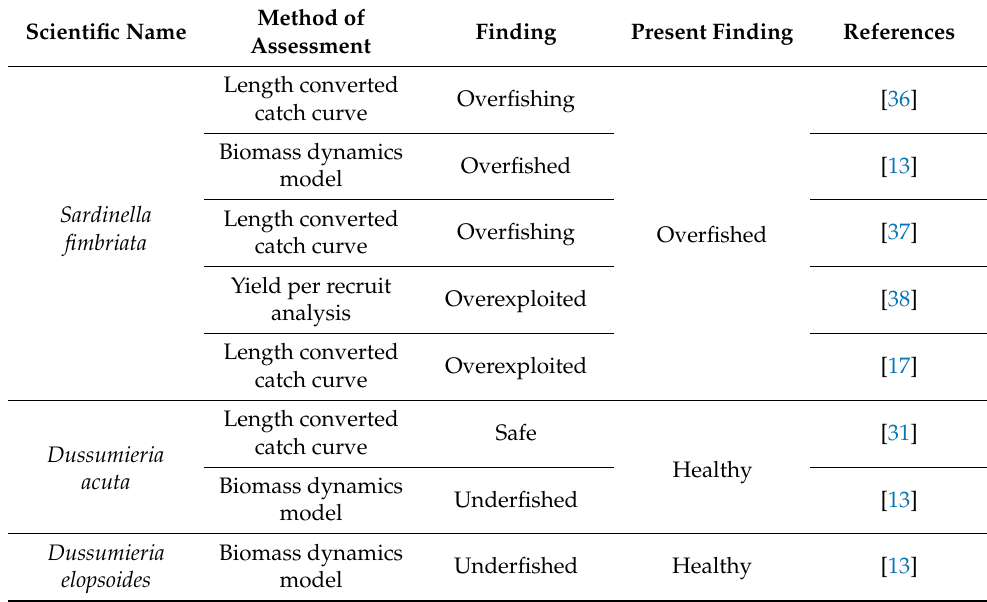
Table 3. Comparative analysis of the current results in light of other pertinent